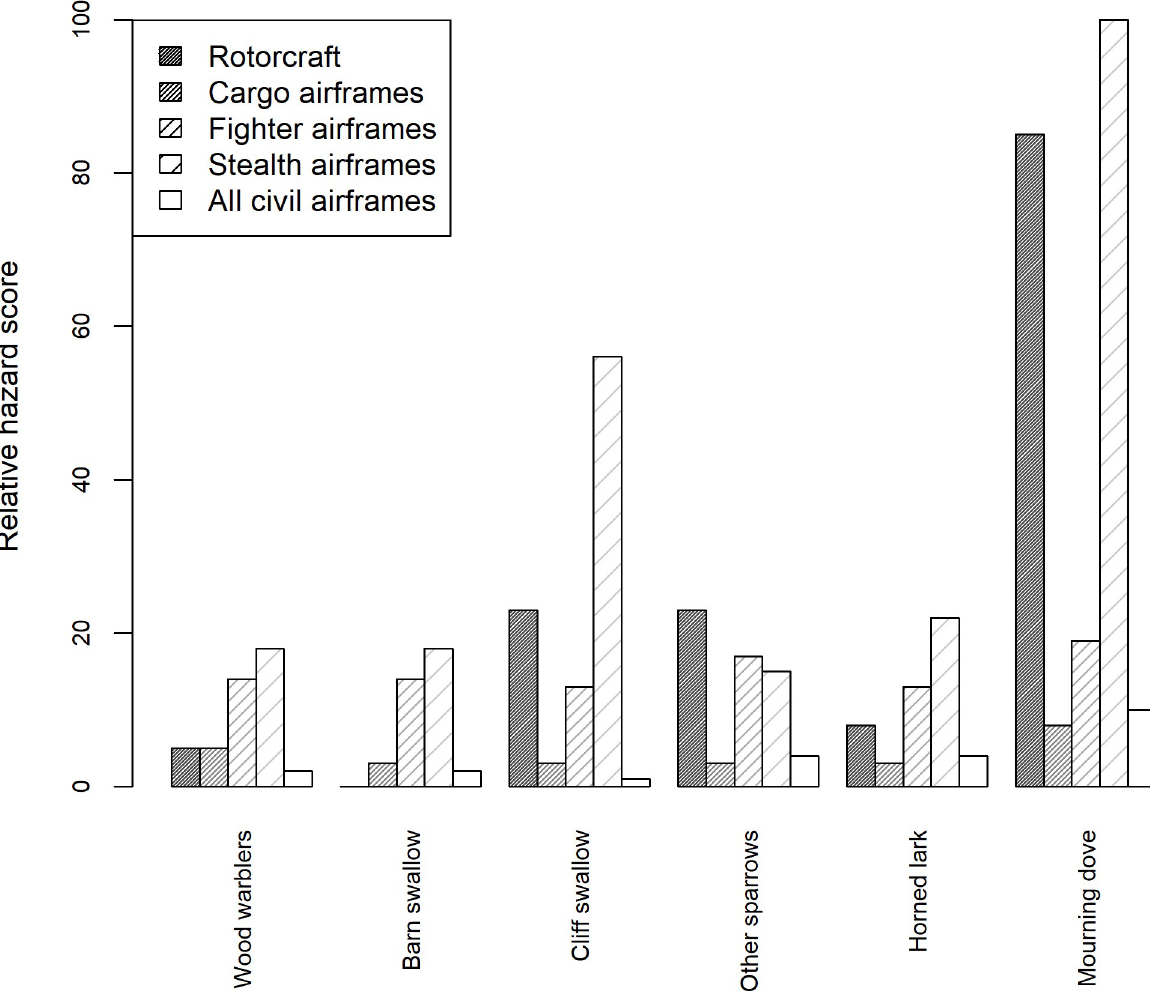
Fig 1. Comparison of relative hazard scores for 6 avian species groups for 4 military airframe groups and all civil airframes for 6 species. Relative hazard scores are calculated from bird strikes within the U.S. See S2 Table for airframe group compositions. Civil relative hazard scores come from [11]. Species are ordered from left to right by ascending averaged body